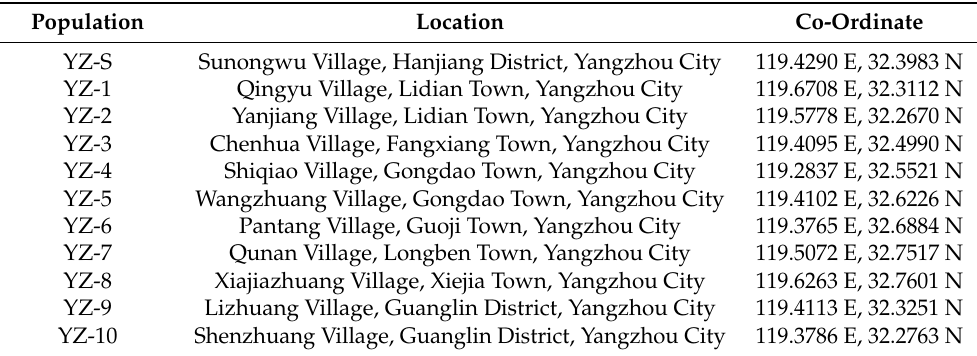
Table 3. Geographical origin of 11 A. auriculata populations collected from paddy fields. Population Location